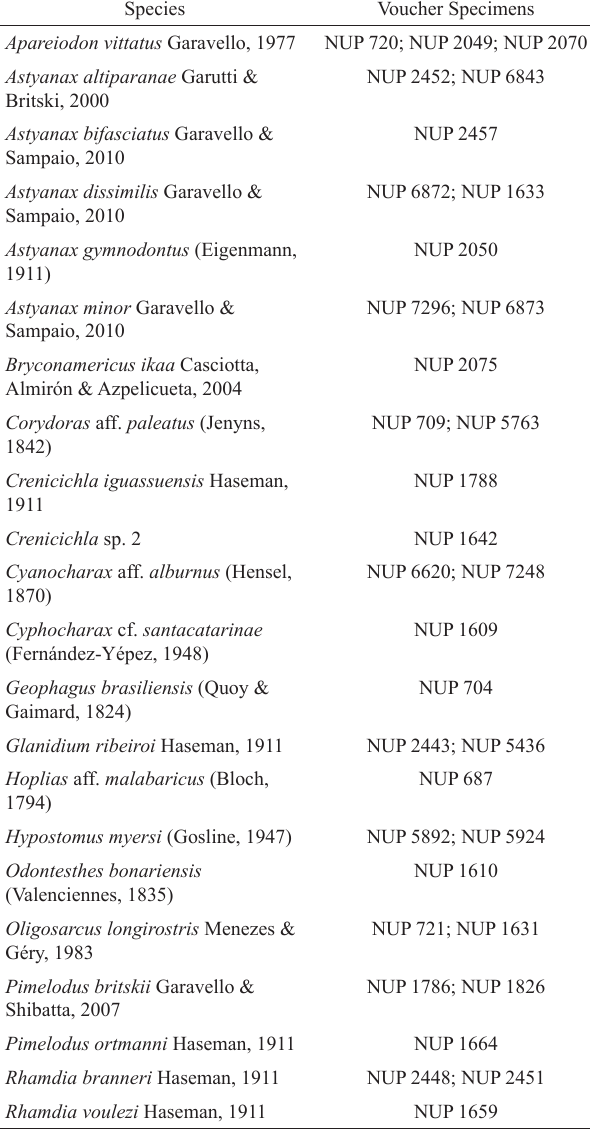
Table 1. List of fish species from the Iguaçu River in the area influenced by the Salto Caxias Reservoir, Paraná State. Voucher specimens: Number of voucher lots deposited in the Fish Collection of Nupélia